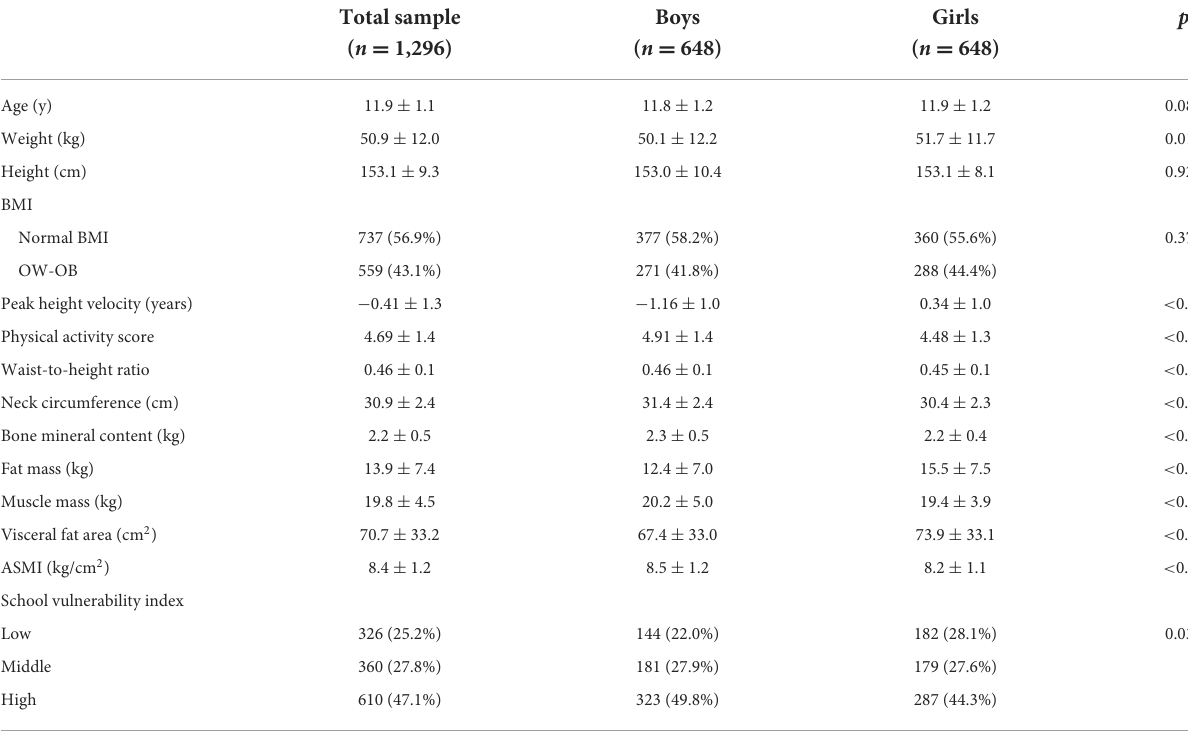
TABLE 1 Participant